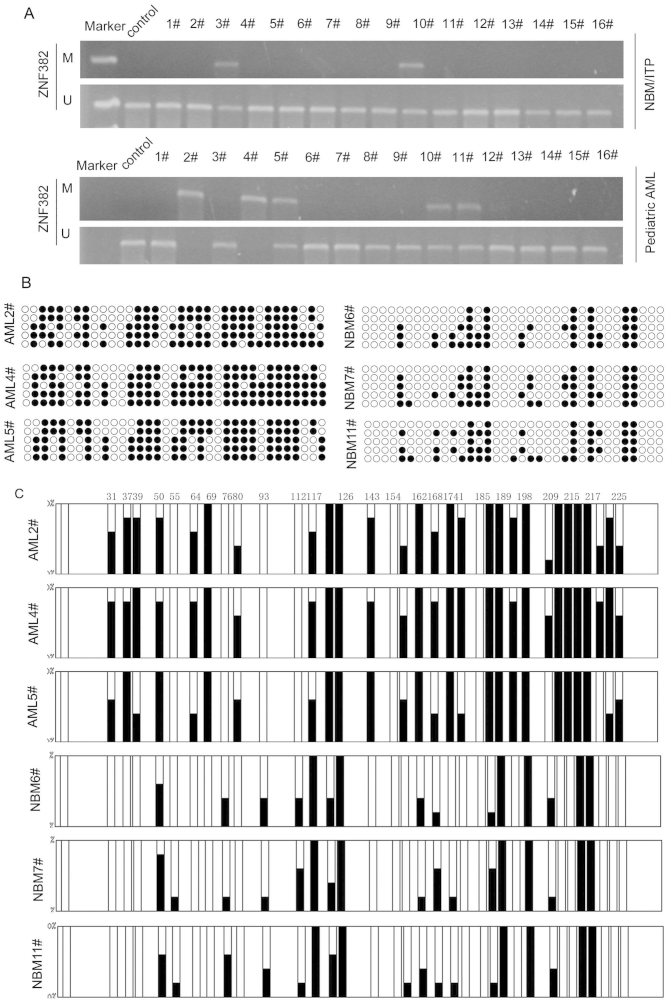
Zinc finger protein 382 (ZNF382) is inactivated by promoter hypermethylation in pediatric acute myeloid leukemia (AML). (A) Methylation-specific PCR (MSP) analysis of the methylation status of ZNF382 shows aberrant methylation in pediatric AML samples compared with normal bone marrow/idiopathic thrombocytopenic purpura (NBM/ITP) control samples. M and U represent MSP results using primer sets for methylated and unmethylated ZNF382 genes, respectively. (B) A total of 3 NBM samples and 3 AML samples were analyzed by bisulfite genomic sequencing (BSG), ●, methylated cytosines; ○, unmethylated cytosines. (C) The results revealed that the CpG islands in the ZNF382 promoter were methylated in the AML samples (63.4, 70.9 and 60.0% in AML2#, AML4# and AML5#, respectively). By contrast, the CpG islands of ZNF382 promoter in the NBM samples were unmethylated (26.3, 29.1 and 29.1% in NBM6#, NBM7# and NBM11#, respectively).